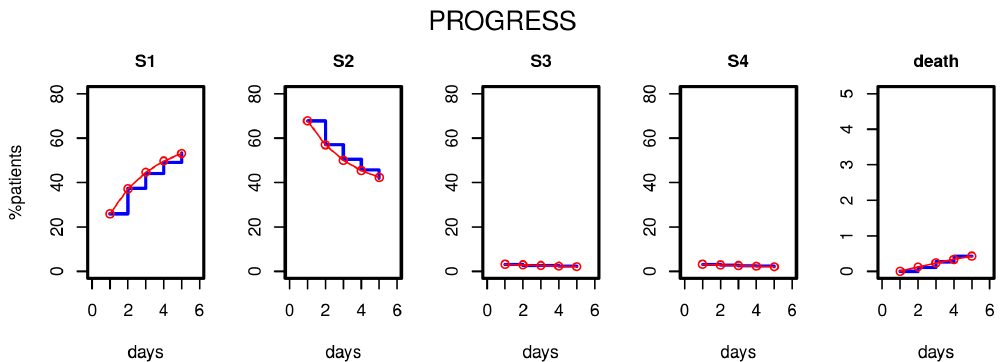
Figure 3. Results of Markov modelling (red curves) in comparison to data of the PROGRESS study (blue curves). Each subfigure shows the proportion of patients in the respective disease states over the first five days. The data fit well with the respective predictions of the Markov model.